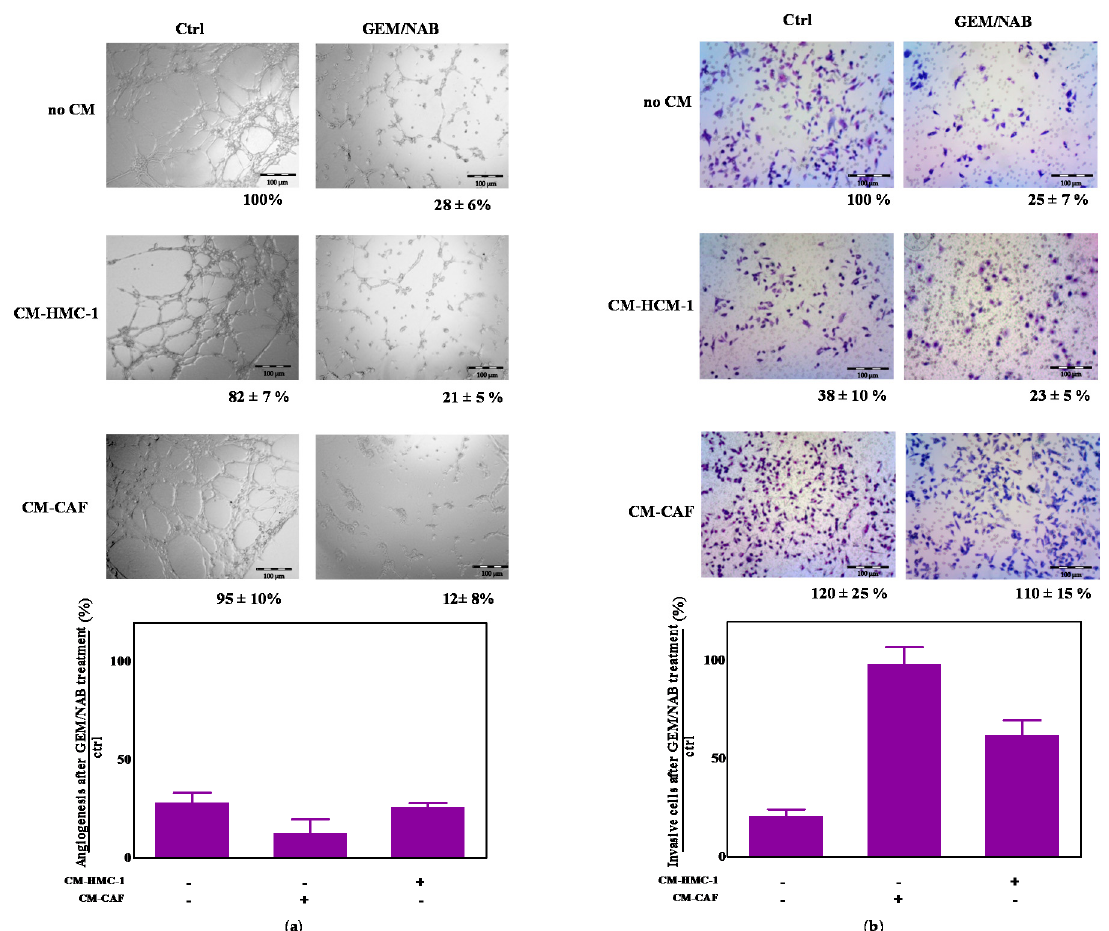
Figure 5. CM-HMC-1 and CM-CAF did not alter GEM/NAB-dependent inhibition of tumor angiogenesis but reduced the efficacy on tumor invasion. ( a ) Capillary morphogenesis. Both CM-HMC-1 and CM-CAF did not alter angiogenesis as demonstrated by microvascular formation and did not reduce the antiangiogenic potential of GEM/NAB. Pictures represent three different experiments. ( b ) Invasion assay. Both CM-HMC-1 and CM-CAF altered tumor invasion, by inducing the decrese and the increase of MIA PaCa-2 invasion, respectively. Both conditioned media reduced the efficacy of GEM/NAB-dependent inhibion of tumor invasion as reported in the histogram plot showing the recovery of tumor invasion on CM-HMC-1/CM-CAF + GEM/NAB treated cells. The pictures represent three different experiments.